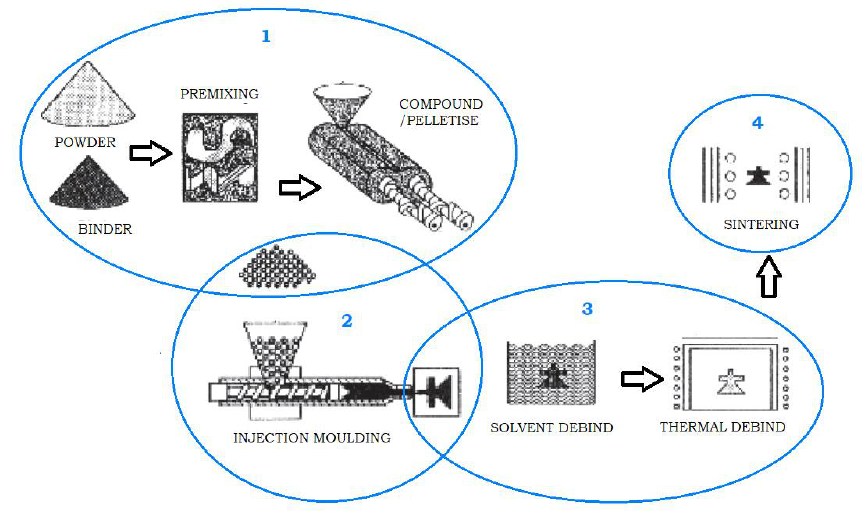
Figure 4. The PIM processing steps combine to produce the desired component